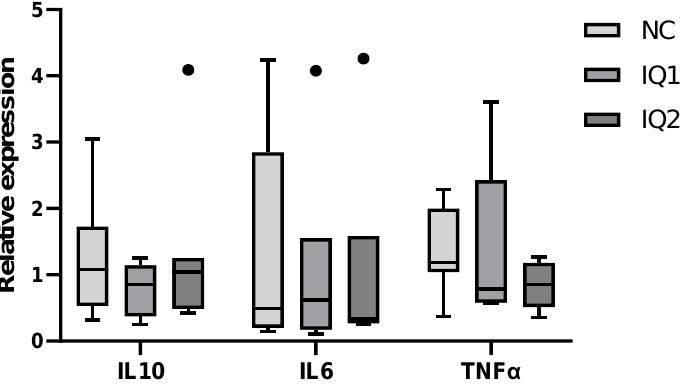
Figure 4. Relative gene expression in ileal tissue of piglets 5 days after weaning on day 21, born from sows that received either a basal diet (NC), or supplementation with isoquinoline alkaloids (IQ) during gestation (90 ppm) and lactation (150 ppm) (IQ1), or only during the lactation period (IQ2). ACTB and GADPH were used as reference genes. A standard dilution curve was used to calculate the relative gene expression of the target genes, using the geometric average of the housekeeping genes ( n = 7/group). Data presented in boxplot: box line + median, mean ± bars (inner fences) and Tukey’s outliers (circles). Statistical differences were considered when p < 0.05.